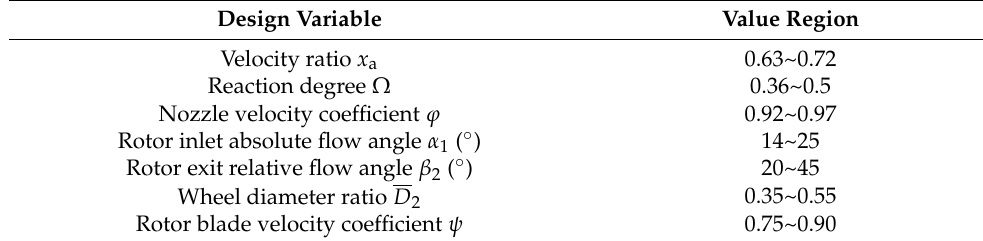
Table 1. Design variable and the relevant value region.